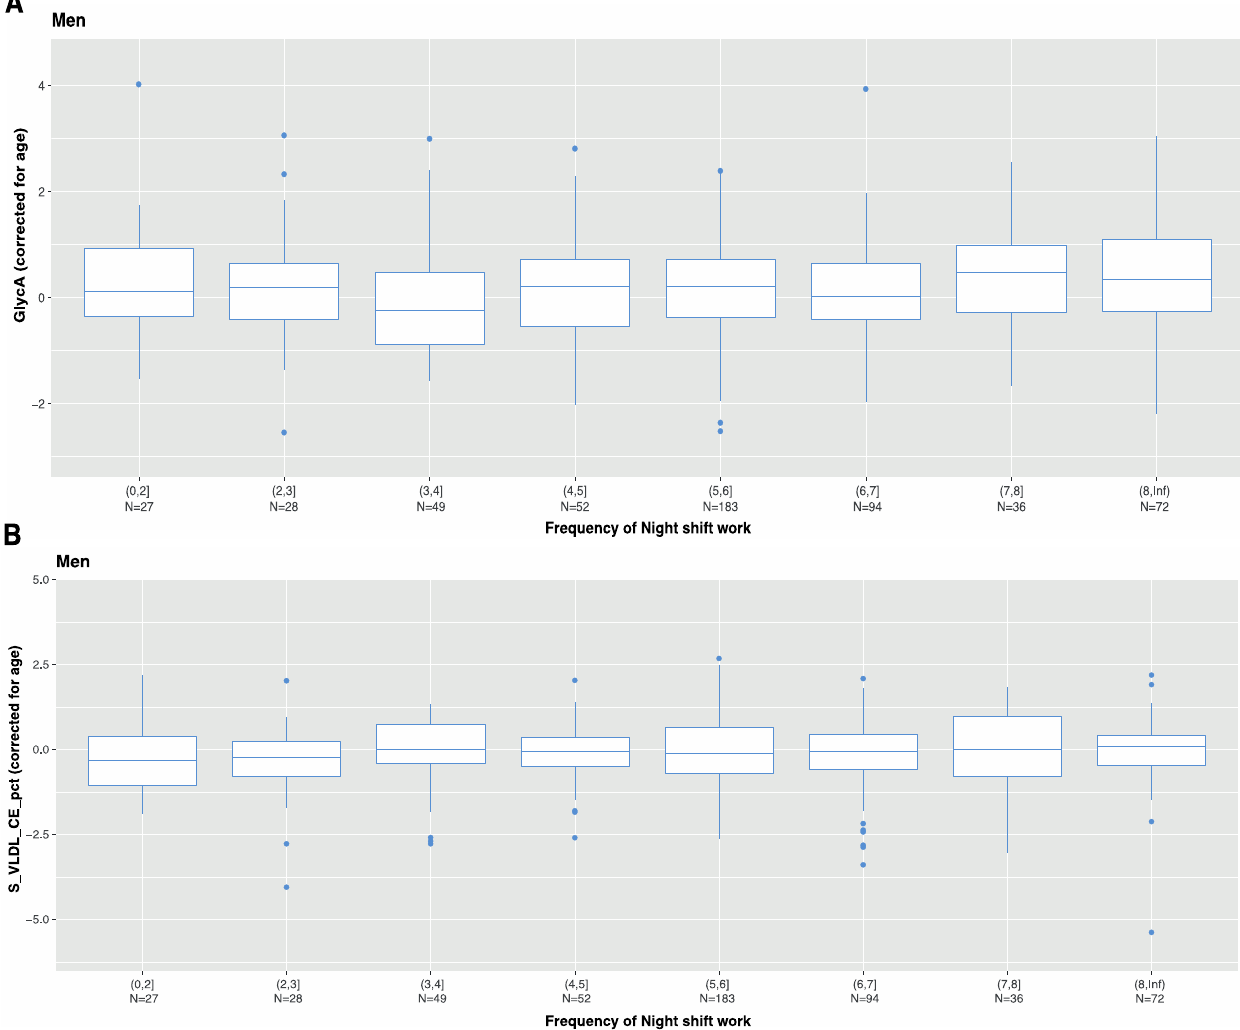
Figure 4. Residuals of ( A ) GlycA and ( B ) S_VLDL_CE_pct after correcting for age among male night